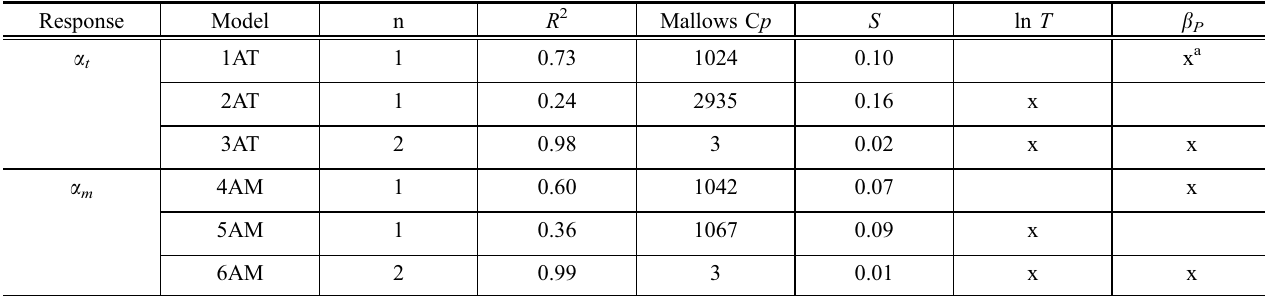
Table 4 The best subset regression analysis of ln a t (or ln a m ) on ln T and b P .